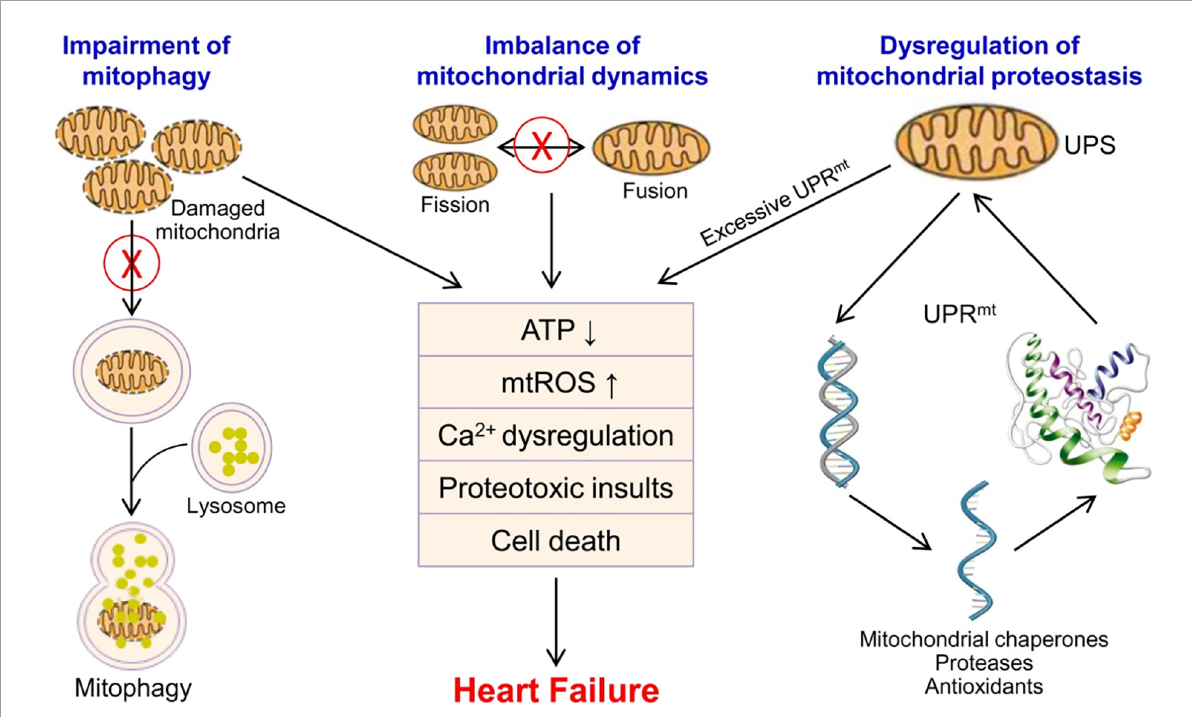
FIGURE1 Mitochondrial quality control and mitochondrial dysfunction in the pathophysiology of heart failure. Mitochondrial quality control mainly includes UPS/UPRmt, mitochondrial fusion and fission, and mitophagy to ensure the number, morphology and function of mitochondria. Mitochondrial dysfunction leads to energy metabolism disturbance, Ca 2 + dysregulation, oxidative stress, proteotoxic insults, and cardiomyocyte death in the heart, and contributes to the progression of heart failure. mtROS, mitochondrial reactive oxygen species; UPS, ubiquitin-proteasome system; UPRmt, mitochondrial unfolded protein